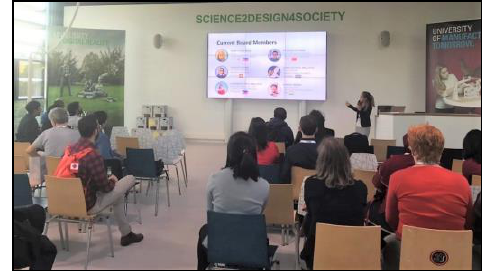
Figure 1. Charmaine Cruz, our Newsletter Editor-in-Chief, Figure 3. The promotional banner of the ISPRS SC Webinar presented the ISPRS SC to the attendees of the Students and Young Professionals Night in the ISPRS Geospatial Week 2019.